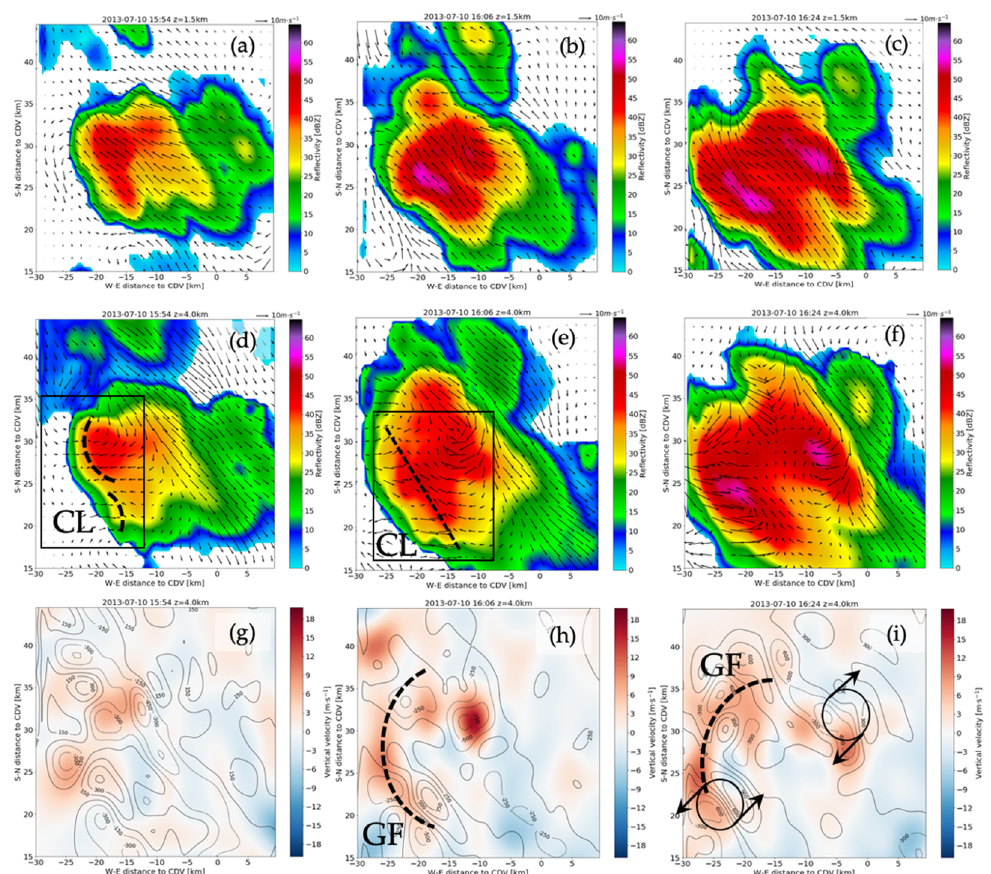
Figure 12. SAMURAI retrievals for the splitting case on 10 July 2013 at Z = 0.5 km (upper row), and Z = 4 km (mid and lower rows). ( a – f ) Reflectivity (dBZ) and storm-relative horizontal wind field (m · s − 1 ) (with black arrows). ( g – i ) Vertical velocity ( w , in m · s − 1 ) and vertical vorticity ( ζ , in 10 − 5 · s − 1 ), represented with black contours (dashed and solid for negative and positive values, respectively). Contours are labeled every 200 × 10 − 5 · s − 1 . Boxes indicate areas of convergence winds, and dashed lines indicate the axis of the convergence line formed by those winds. CL and GF labels indicate convergence line and gust front, respectively. Black arrows indicate the two final vortex couplets.